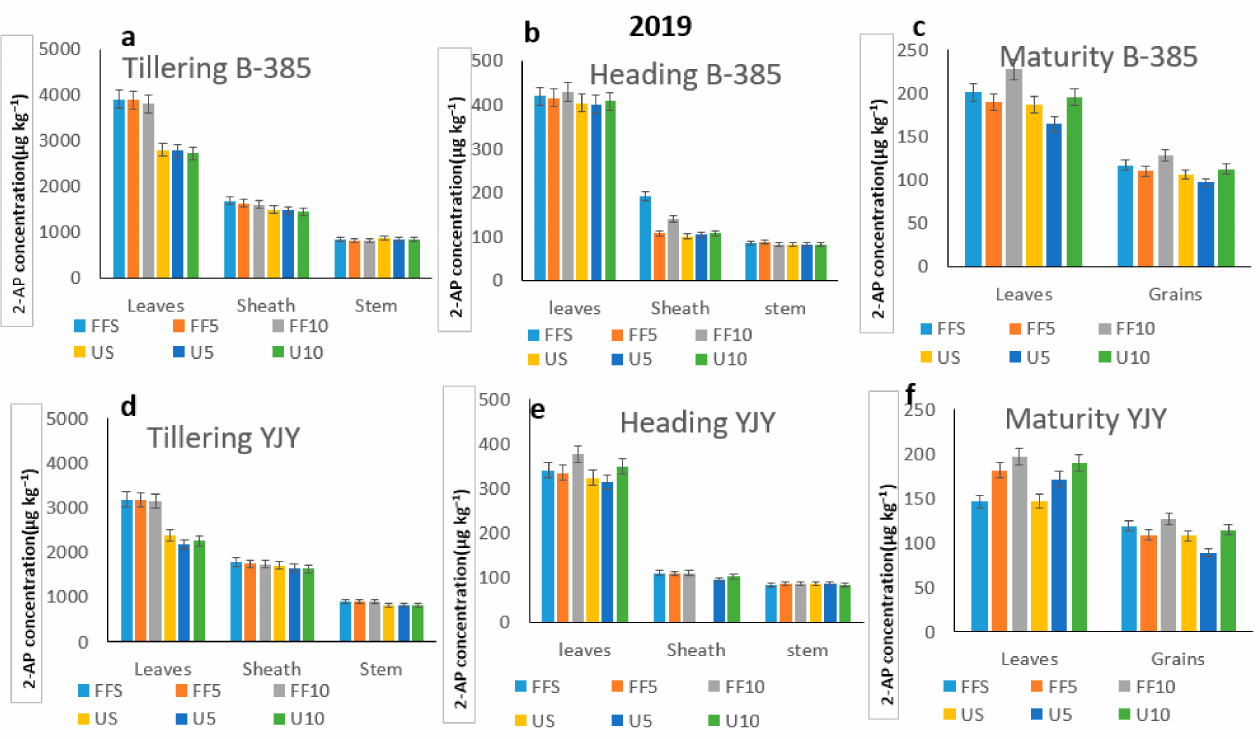
AP contents ( µ g kg − 1 ) of different cultivars under fertilizer application in